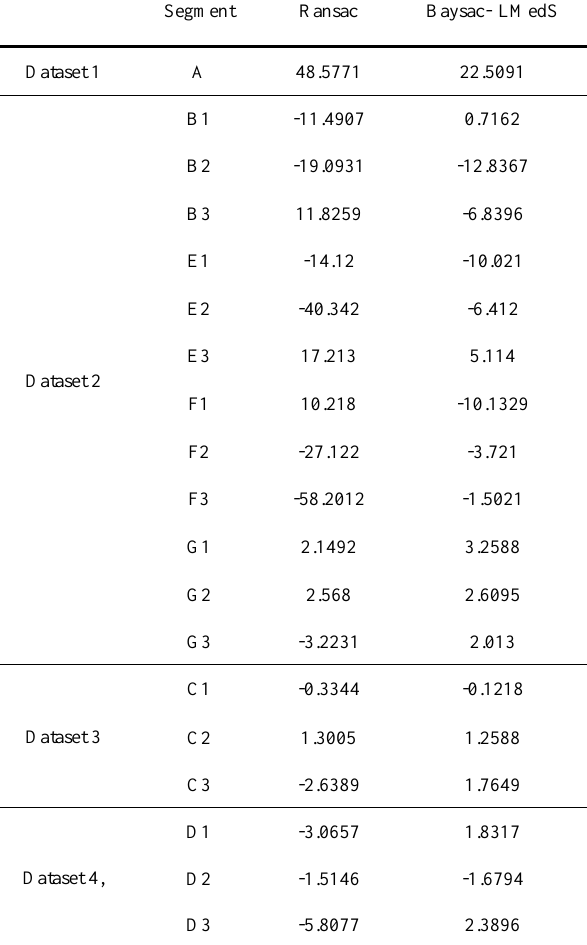
Figure 7. The statistical histograms and spatial distributions of average point-to-surface residuals per cell (Segment D1). ( a ) BaySAC- LMedS; ( b ) RANSAC. Table 5. Average point to surface residuals (non-random)